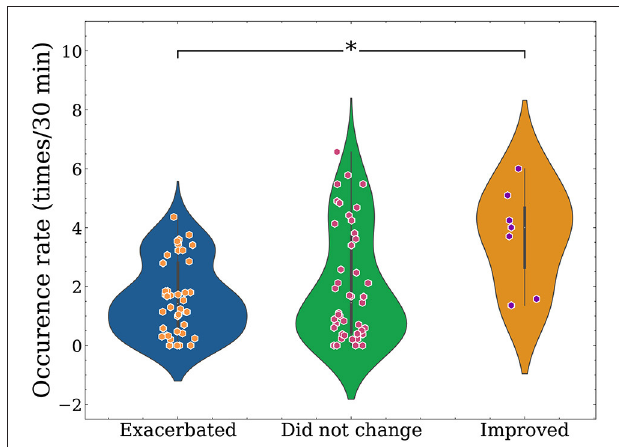
FIGURE 6 | Differences in occurrence rate of motif at three LBP conditions, the figure is the scatter plot with the addition of a rotated kernel density plot on each side. The occurrence rate was higher in the improved group. * p